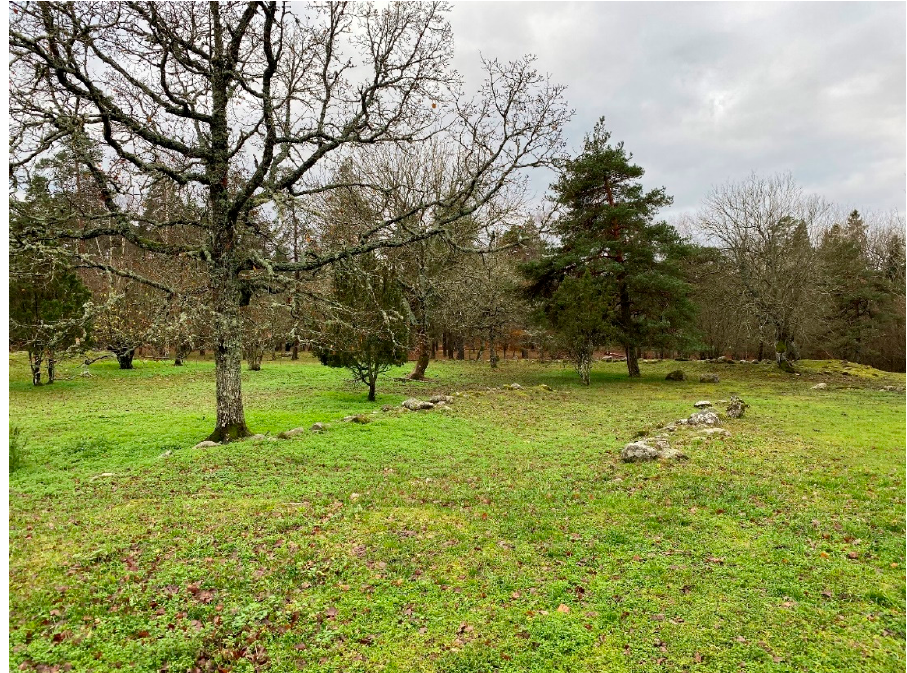
Figure 6. Aränget (Bäl parish, Gotland). The house foundation (east-west) located furthest to the northeast, outlined by the stone walled foundation. Its location is marked by a yellow arrow in Figure 5. In the background another of the house foundations (northwest-southeast) is slightly visible. This type of house foundation generally dates from between AD 200 and 600 based on excavation, with a few exceptions extending the timespan. Photo: Daniel Langhammer,